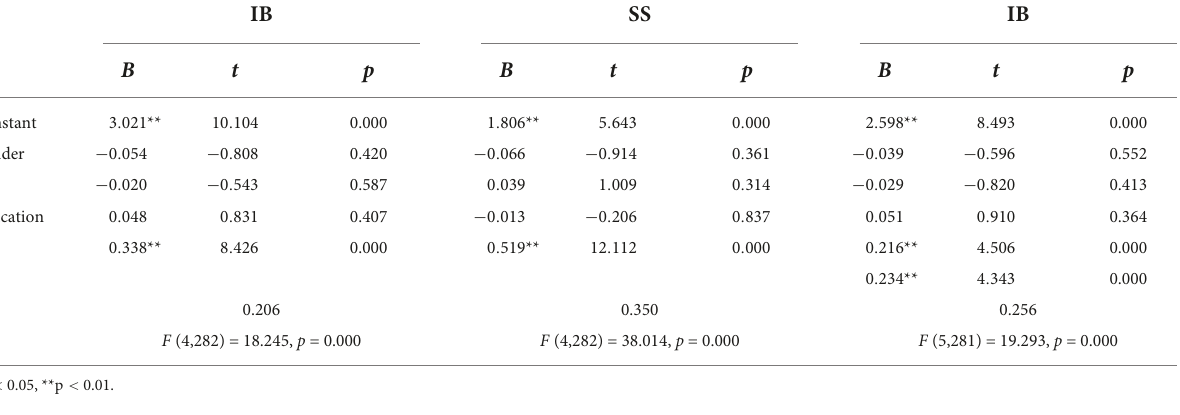
TABLE 8 Mediating effects of EB ( n = 287).